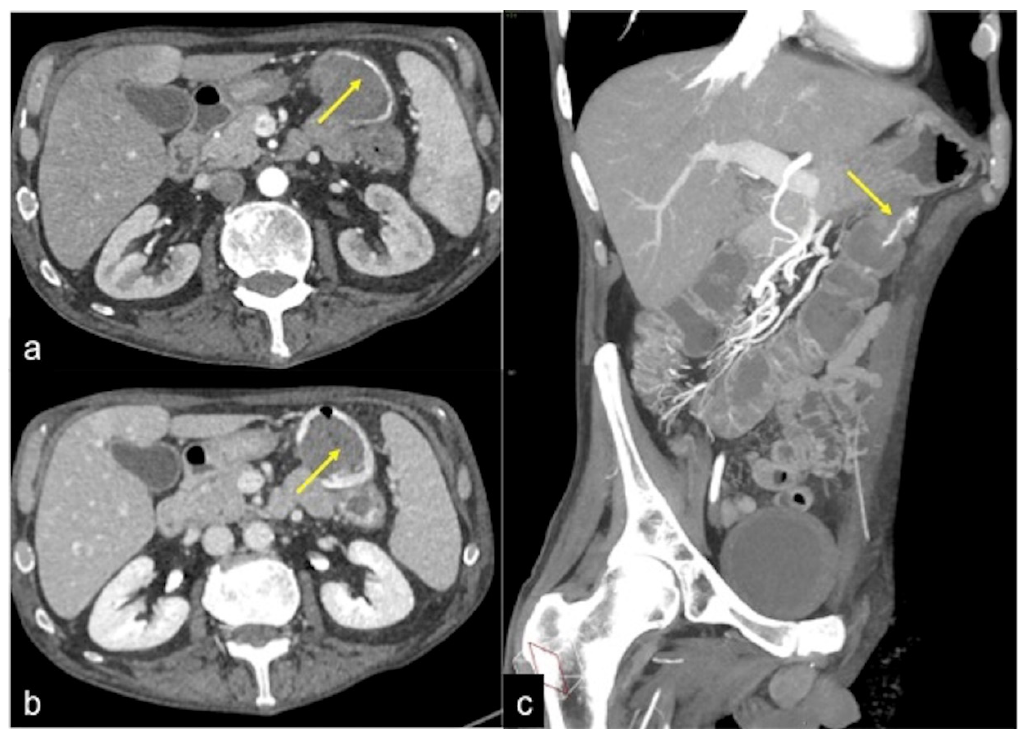
Figure 12. CTA arterial phase ( a ) and relative MIP reconstruction ( b ) of a haemorrhagic spot in the descending colon.